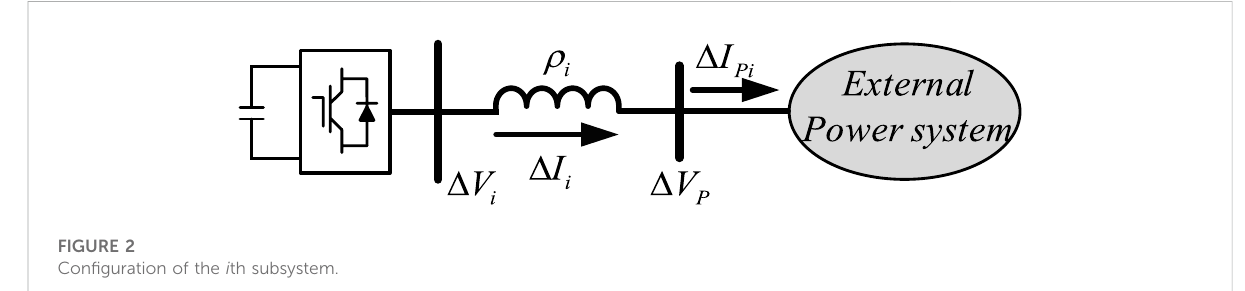
FIGURE 2 Con fi guration of the i th